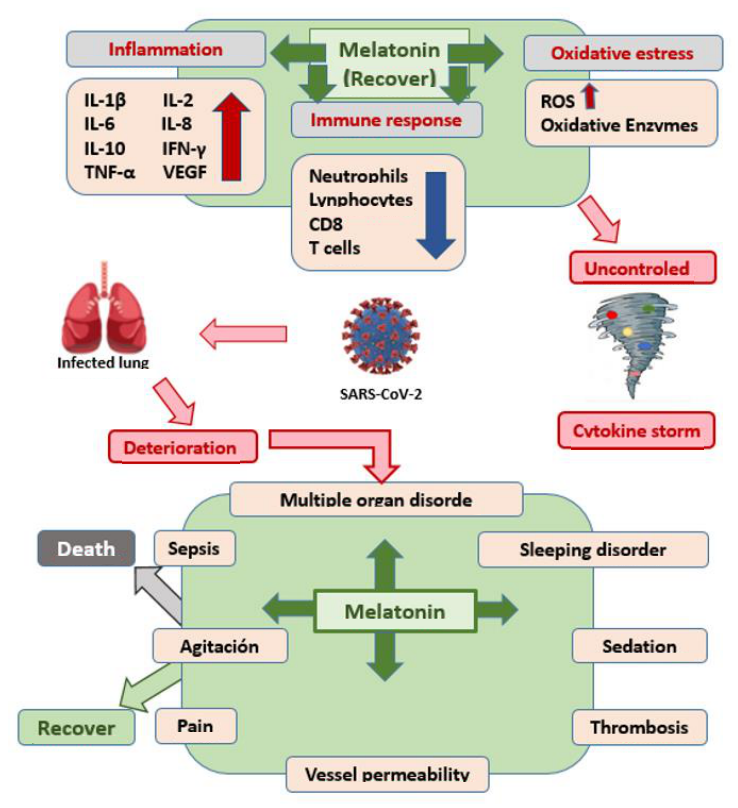
Figure 4. Mechanism of action of melatonin against SARS-CoV-2.